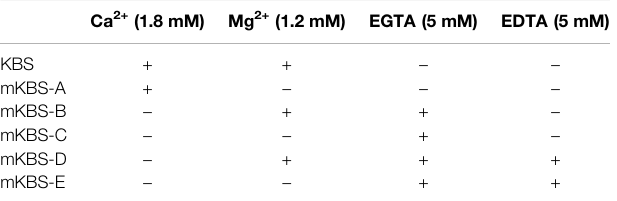
TABLE 1 | Modi fi ed KBS solutions (mKBS) in which activities of released eATPase(s) were